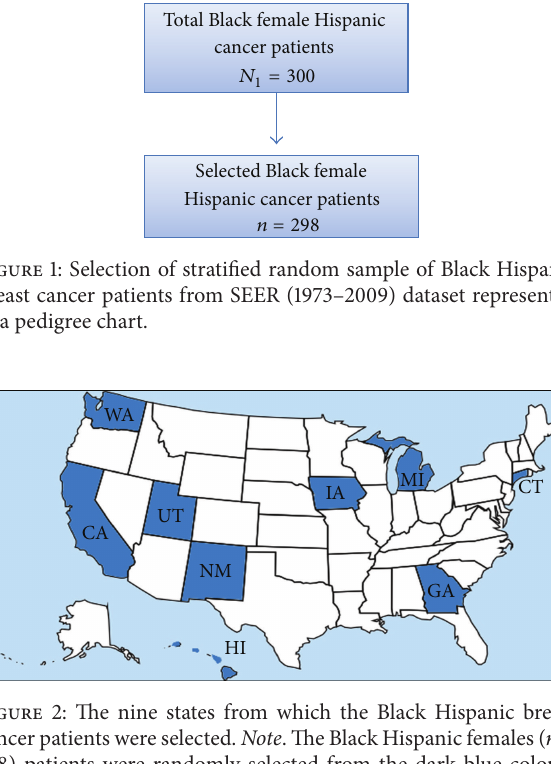
Table 2: Given below is the marital status, survival time, and age at diagnosis for female Black Hispanic breast cancer patients. Age at diagnosis and survival time are classified by mean, standard deviation (SD), median, range, and quartiles. Marital status is classified into six categories and their respective frequencies are